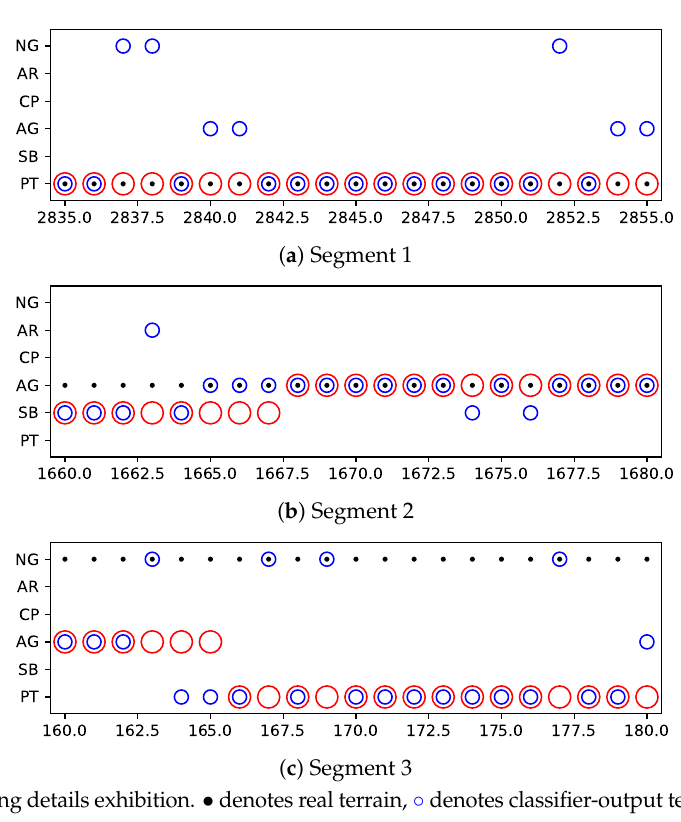
Figure 8. Filtering details exhibition. • denotes real terrain, ◦ denotes classifier-output terrain predictions, ◦ denotes filter-output terrain predictions. NG, AR, CP, AG, SB, PT denote natural grass, asphalt road, cobble path, artificial grass, sand beach, plastic track,